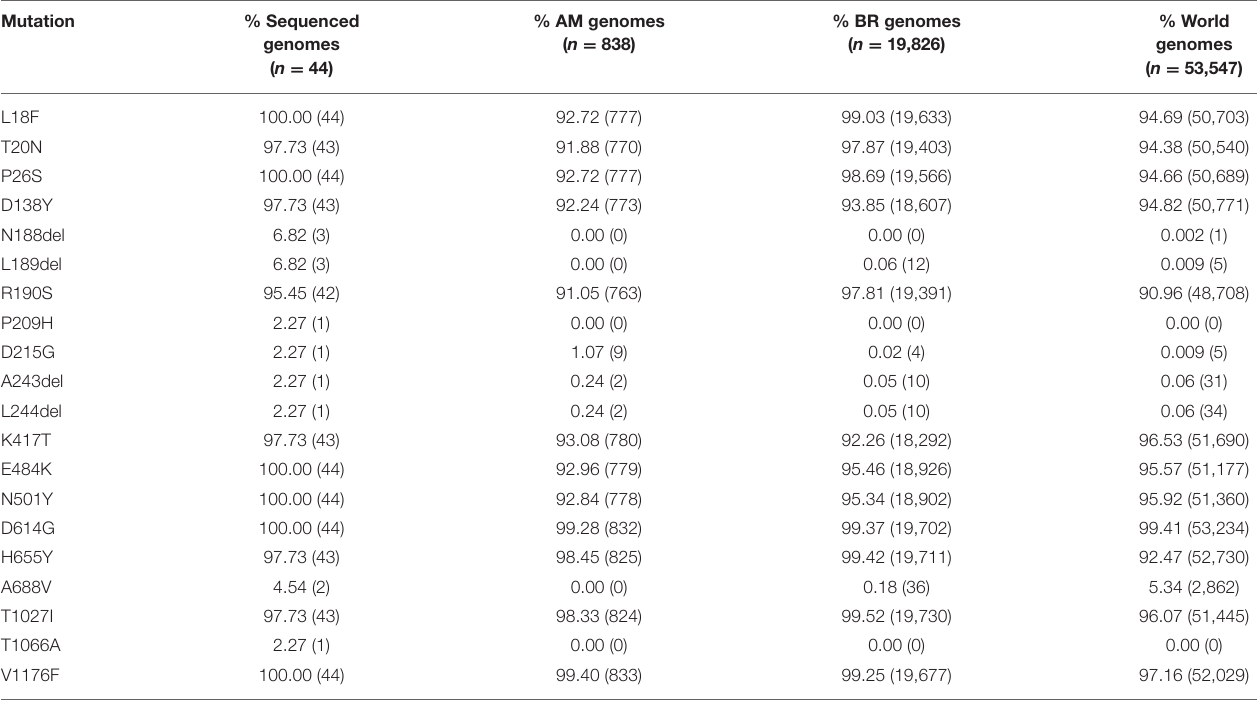
TABLE 1 | Frequency of spike mutations identified in the P.1 sequenced genomes (this study) compared with sequences from Amazonas, Brazil and World (up to September 12, 2021) available on GISAID. % AM genomes Mutation % Sequenced ( n = genomes ( n = 44)